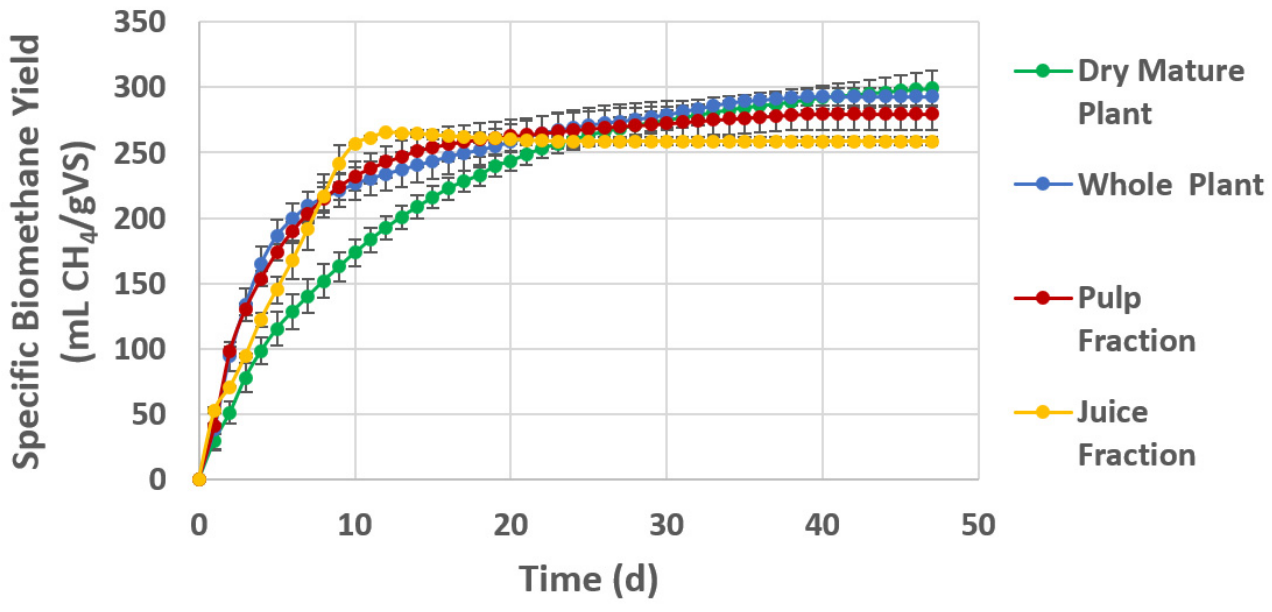
Figure 3. Cumulative BMP of S. ramosissima cultivated through saline water irrigated greenhouse farming as whole green plant, dry mature plant and pulp and liquid fraction after fractionation. Values of each curve represent the average biomethane yield and standard deviation of triplicate BMP batch assays.